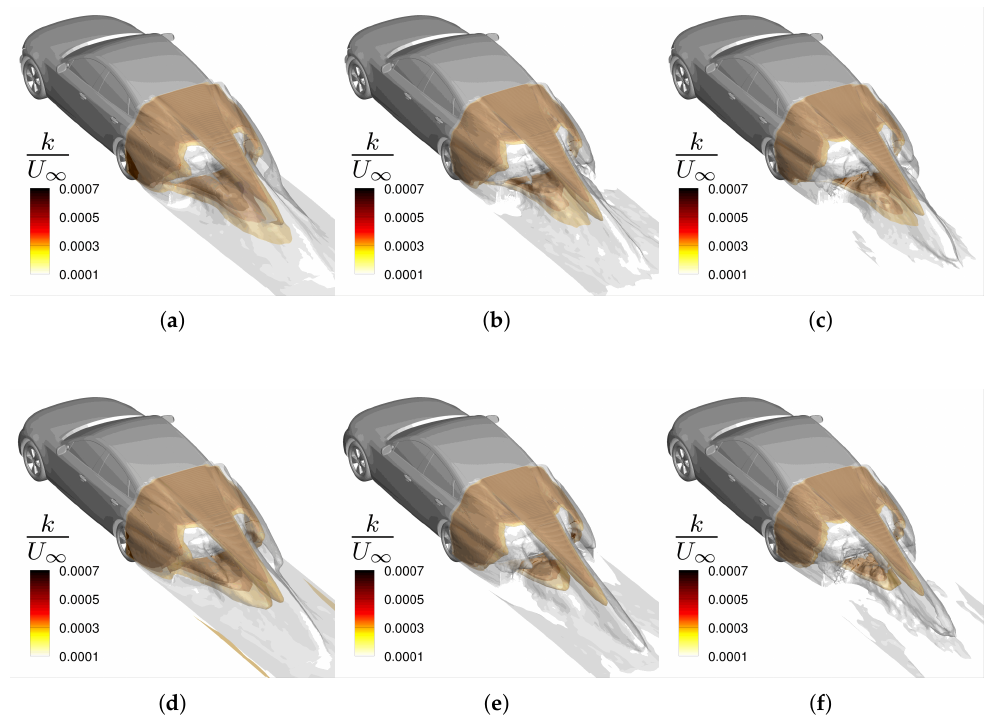
Figure A1. Iso-surfaces of the turbulent kinetic energy k / U 2 ∞ for the ( a ) coarse (stationary wheels), ( b ) medium (stationary wheels), ( c ) fine (stationary wheels), ( d ) coarse (rotating wheels), ( e ) medium (rotating wheels), and ( f ) fine (rotating wheels)